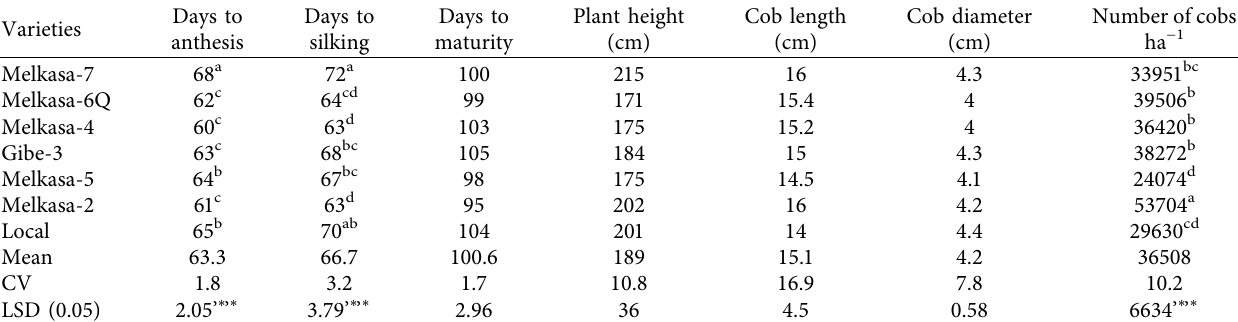
Table 3: Mean morphological and yield-related performance of open-pollinated maize varieties in 2018.